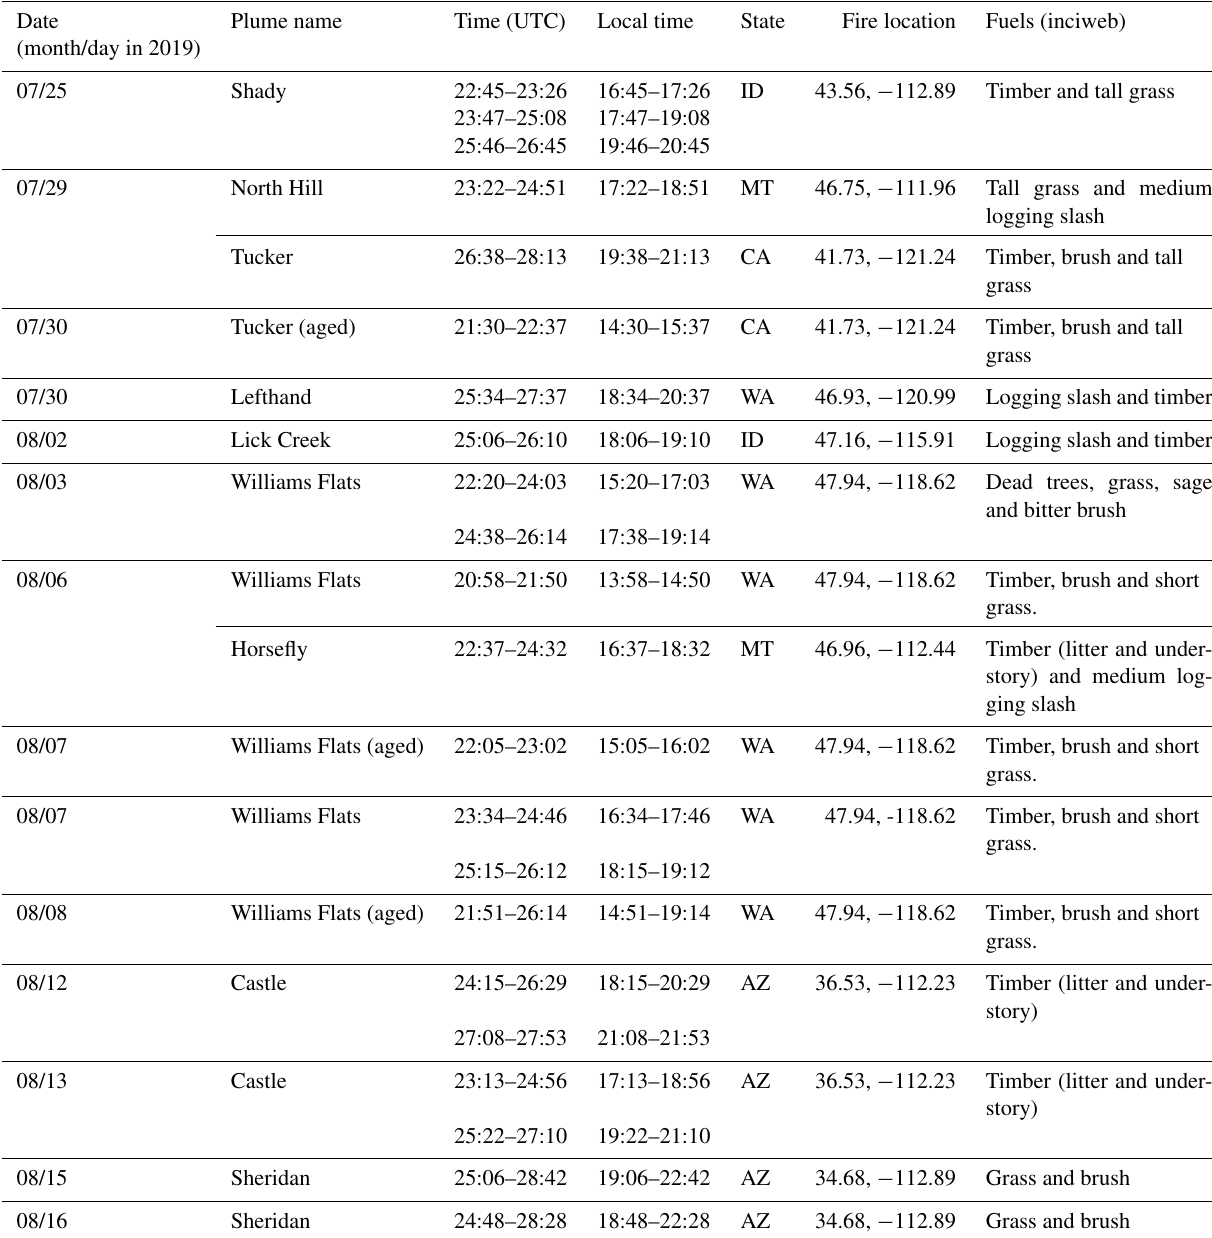
Table 3. Details of the wildfire plumes encountered in the western United States during FIREX-AQ 2019 by the NASA DC-8 aircraft. The date (month/day) and time are at the point when the aircraft starting sampling in the plumes (note that UTC may exceed 24:00 to ensure continuity). Except for plumes in CA and WA, which are in the PDT time zone, local time for plumes encountered in other states is in